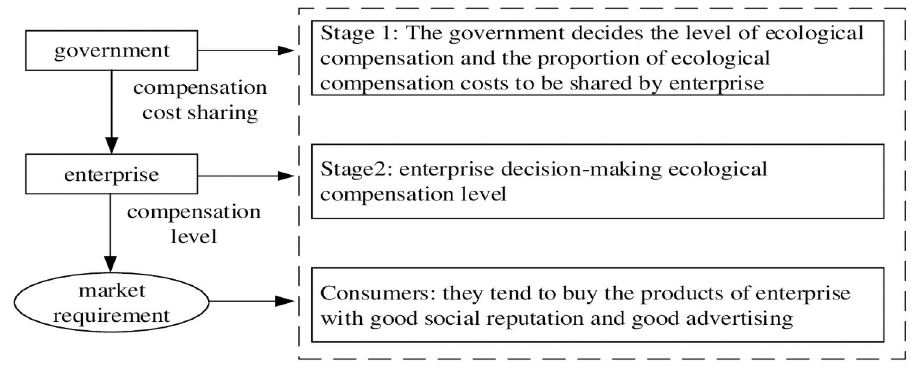
Fig 1. Decision-making of ecological compensation by government and enterprise.